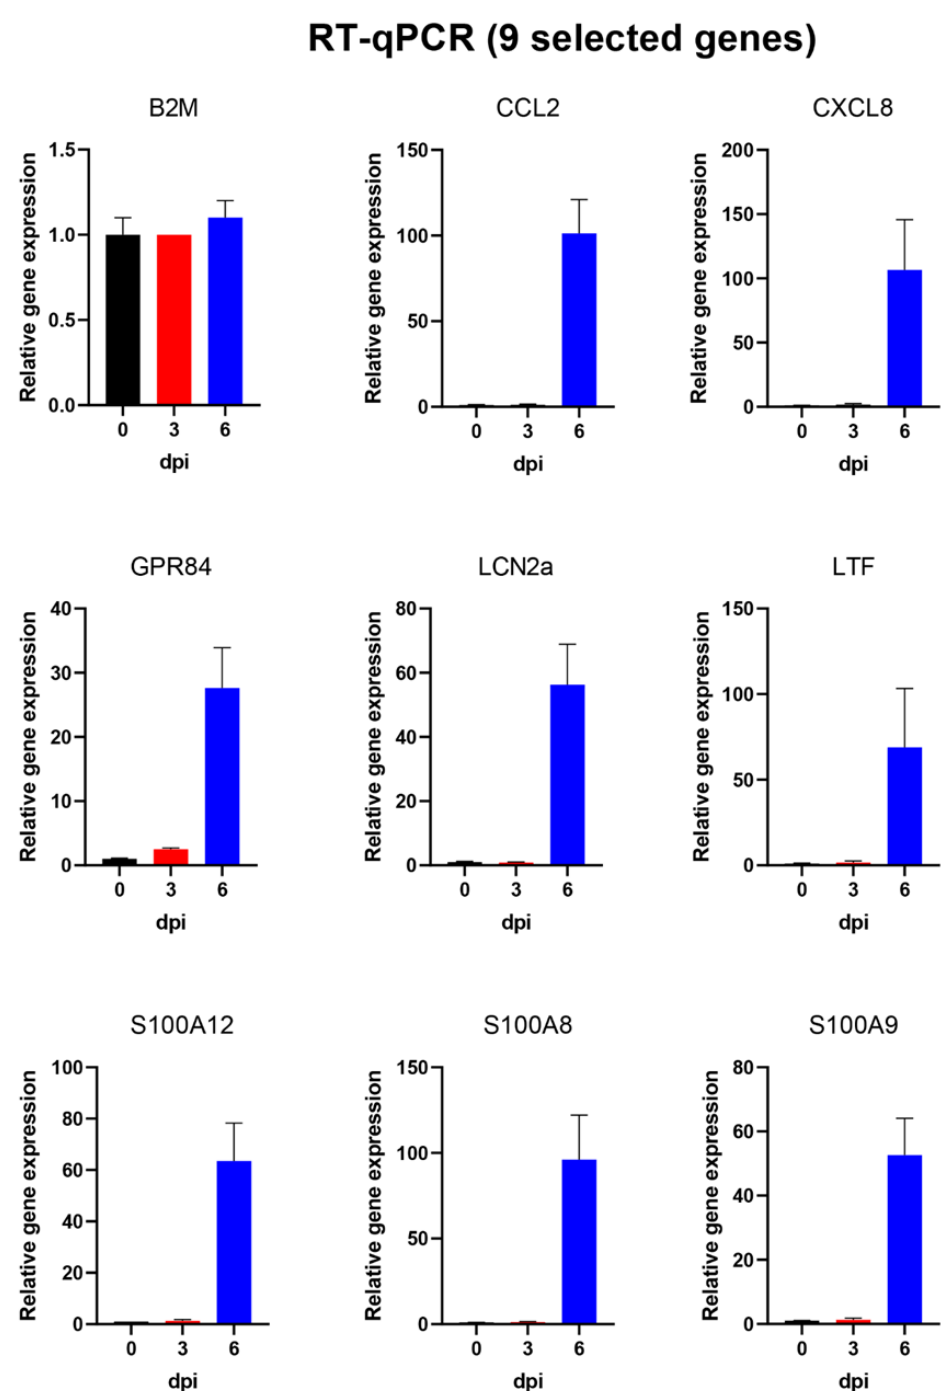
Figure 6. Expression of 9 selected host genes in PBMCs from ASFV-infected pigs as determined by RT-qPCR. The relative levels (mean + SEM for 4 pigs) of 9 selected genes, as determined by qPCR assays, are shown for the PBMCs collected at 0, 3 and 6 dpi. The expression of B2M was expected to be unchanged and acted as a reference gene. All the other genes shown here were expressed at about 30–100-fold higher levels at 6 dpi compared to 0